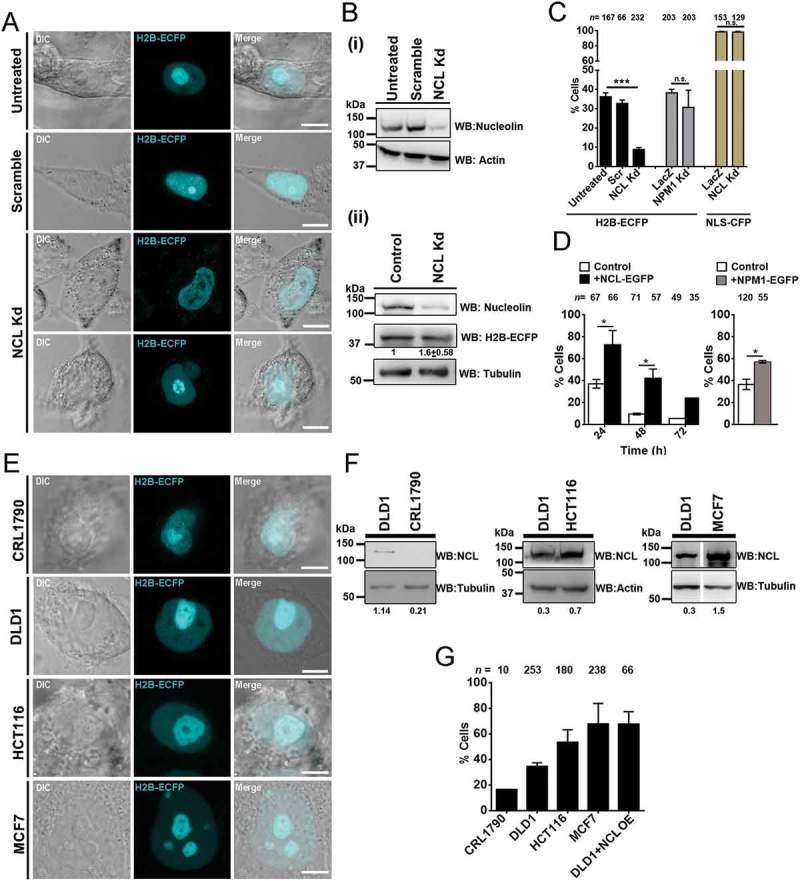
Nucleolin levels modulate compartmentation of H2B-ECFP in the nucleolus. (a) Representative images from live imaging of H2B-ECFP upon Nucleolin knockdown (NCL Kd) in DLD1 cells. Controls: untreated and scrambled siRNA treated cells. Scale bar ~5 µm. (b) (i) Western blots performed on whole cell lysates to detect Nucleolin levels in untreated, scramble and NCL siRNA treated DLD1 cells. Loading control: Actin. (ii) H2B-ECFP expression is marginally increased upon Nucleolin knockdown. Loading control: Tubulin. (c) Percent cells showing nucleolar H2B-ECFP compartments upon NCL Knockdown (Kd), n = number of nuclei, data from N = 3 independent biological replicates, error bars: SEM. Percent cells showing nucleolar H2B-ECFP upon NPM1 knockdown, n = number of nuclei, data from N = 2 independent biological replicates, error bars: SD. Percent cells showing nucleolar NLS-CFP upon NCL Kd, n = number of nuclei, data from N = 2 independent biological replicates, error bars: SD. Student’s t-test, ***p < 0.001. (d) Nucleolar H2B-ECFP upon NCL-GFP overexpression. DLD1 cells transfected with H2B-ECFP only (control, white bars) and co-transfected with H2B-ECFP and NCL-GFP (+NCL-GFP, black bars) imaged at intervals of 24, 48, and 72 h post transfection. Percent cells showing nucleolar H2B-ECFP upon 24 h of NPM1-GFP overexpression, n = number of nuclei, data from two independent biological replicates, N = 2, error bars: SD. (e) Representative images from live imaging H2B-ECFP transfected CRL1790, DLD1, HCT116 and MCF7 cells showing nucleolar localization of H2B-ECFP. Scale bar ~5 µm. (f) Western blots showing endogenous levels of NCL in CRL1790, DLD1, HCT116, and MCF7 cells. Loading controls: Tubulin, Actin. Intensity of Nucleolin normalized to loading control. (g) Extent of H2B-ECFP in the nucleolus in CRL1790, DLD1, HCT116, MCF7 cells and in DLD1 cells co-transfected with NCL-GFP, n = number of nuclei, data from two independent biological replicates, N = 2.